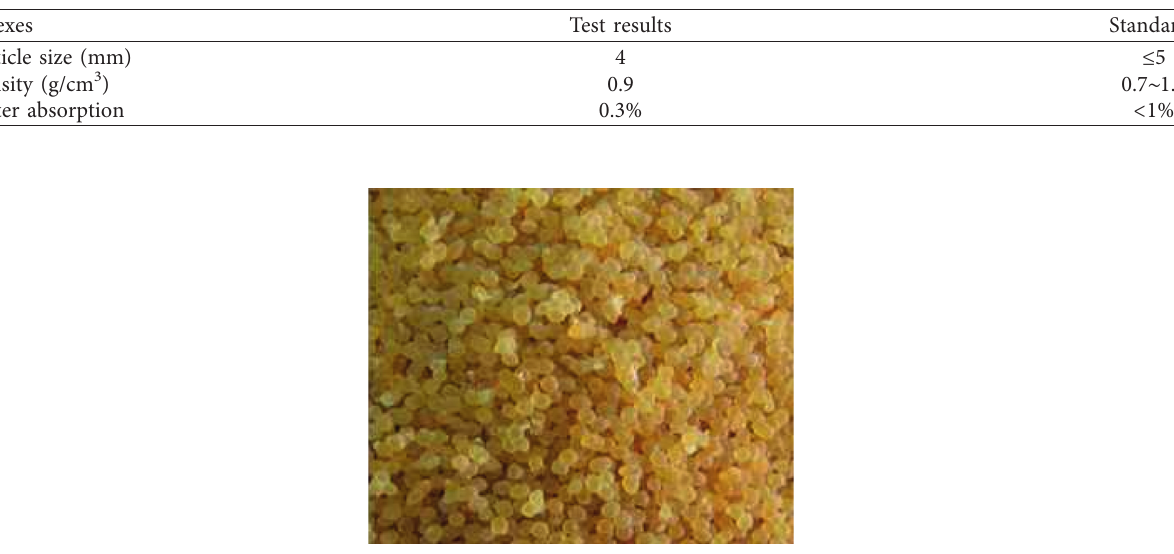
Figure 4: TPS modifying agent for